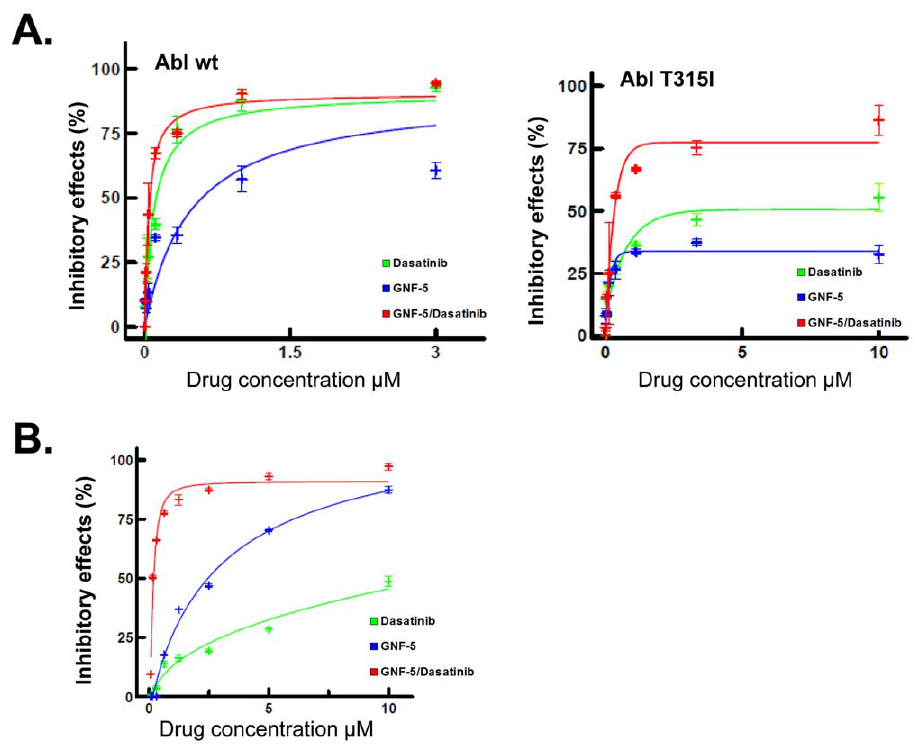
Figure 1. Inhibition of Abl proteins with compounds alone or in combination. A . Enzymatic inhibition ( in vitro ) of recombinant wild-type and T315I Abl by dasatinib, GNF-5 and combination treatments. Percent inhibition of wt Abl or T315I Abl by dasatinib and GNF-5 or the combination. The combination curve (red) contains twice the total drug concentration of the single agent curves due to both drugs being present. B . Synergistic inhibition of Bcr-Abl T315I transformed Ba/F3 cells. Dose and effect curve of GNF-5, dasatinib and the combination of GNF-5 and dasatinib (1:1 ratio) on Bcr-Abl T315I transformed cells. The combination curve (red) contains twice the total drug concentration of the single agent curves due to both drugs being present. C . CI values for fractional growth inhibitions of 0.50, 0.75, and 0.90 in Bcr-Abl T315I cells. Antagonism CI . 1.00; additivity CI=1.00; synergy CI , 1.00.